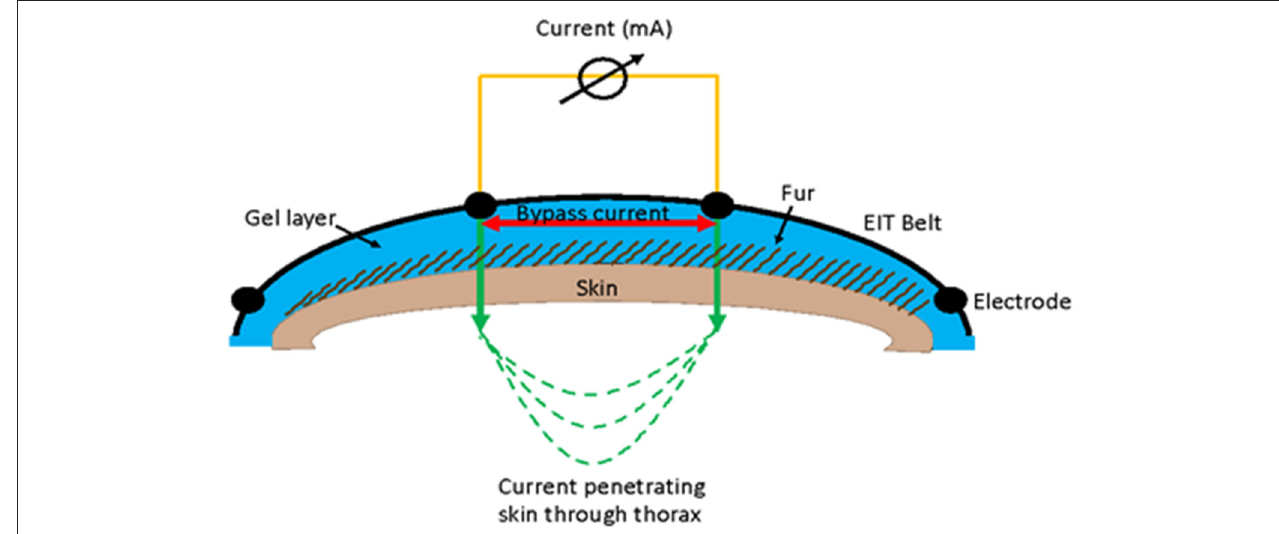
FIGURE 8 | Illustration of the use of gel in EIT measurement and how a bypass current can occur between electrodes where the current flows in the gel layer (red arrow) rather than going through the skin (green